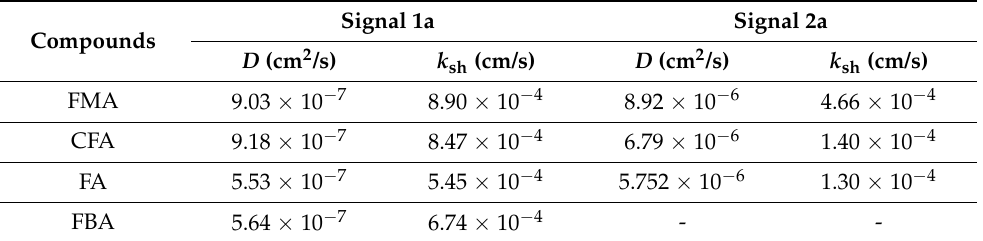
Table 3. D and k sh values for quasi-reversible and irreversible systems for all studied ferrocenyl derivatives. Compounds